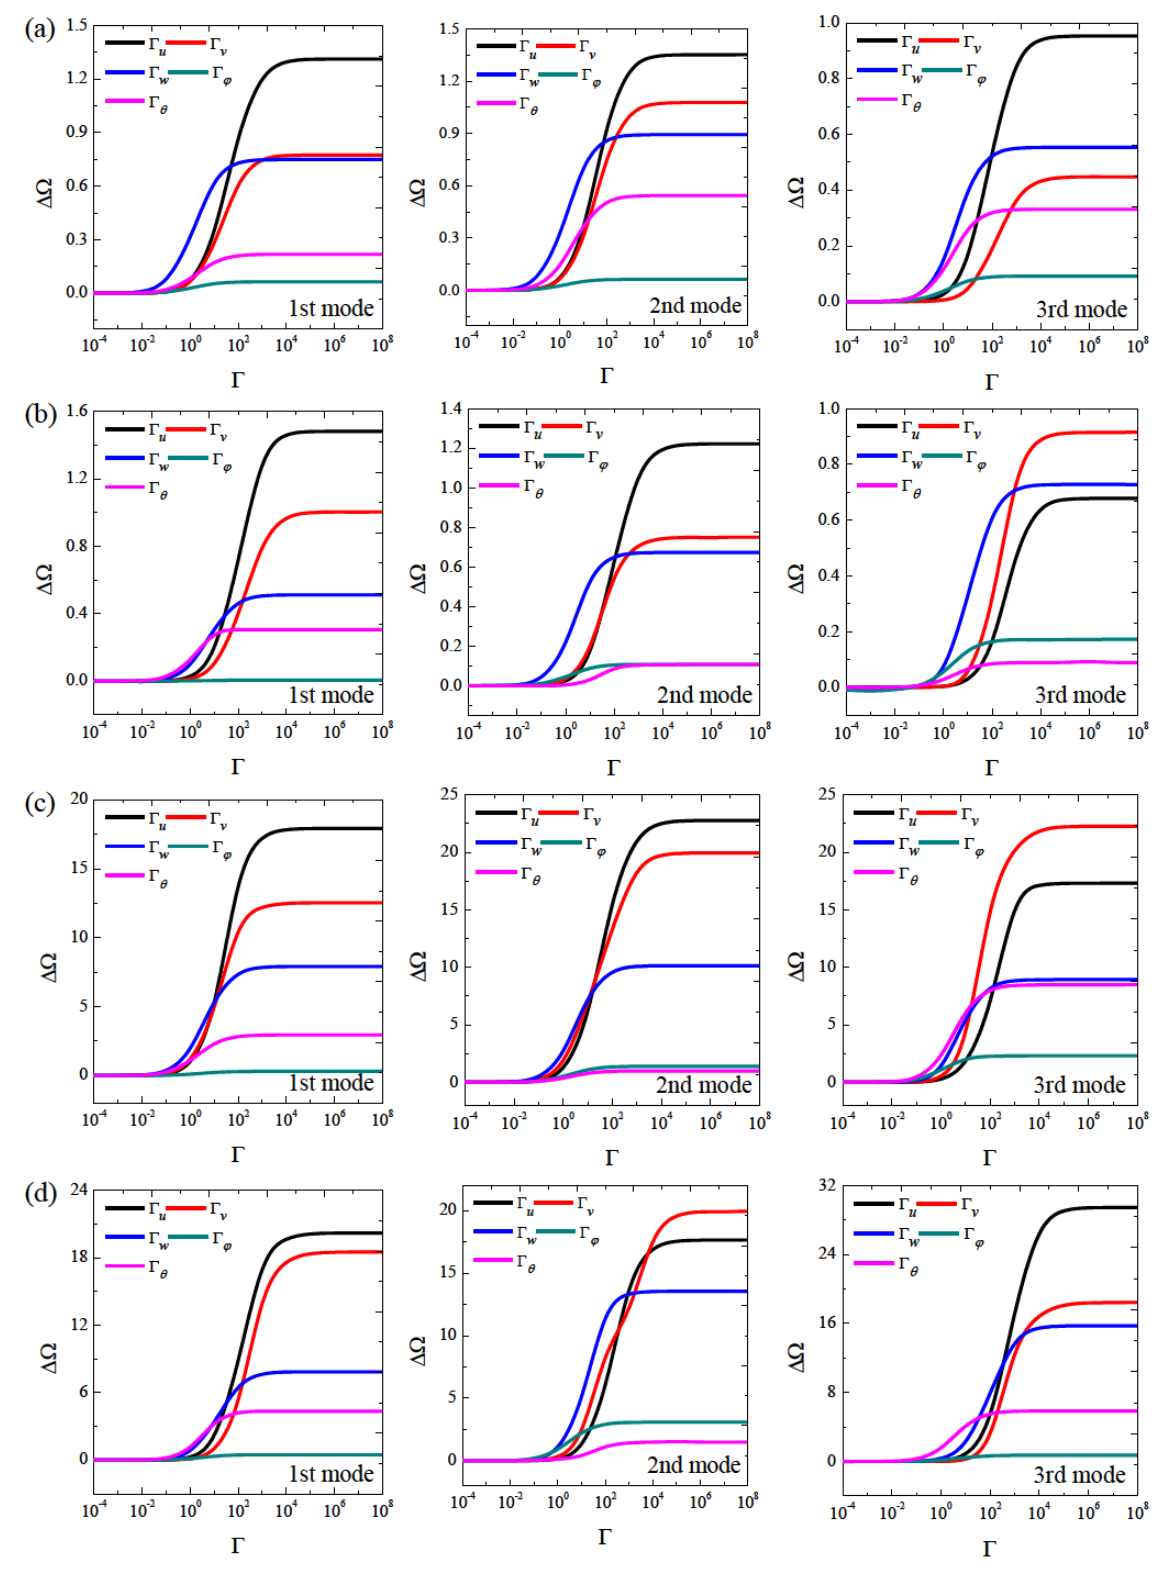
Figure 10: Variation of the frequency parameters ∆Ω versus the elastic restraint parameters Γ for FG panels: (a) Toro-parabolic panel; (b) Parabolic panel; (c) Toro-circular panel; (d) Toro-circular